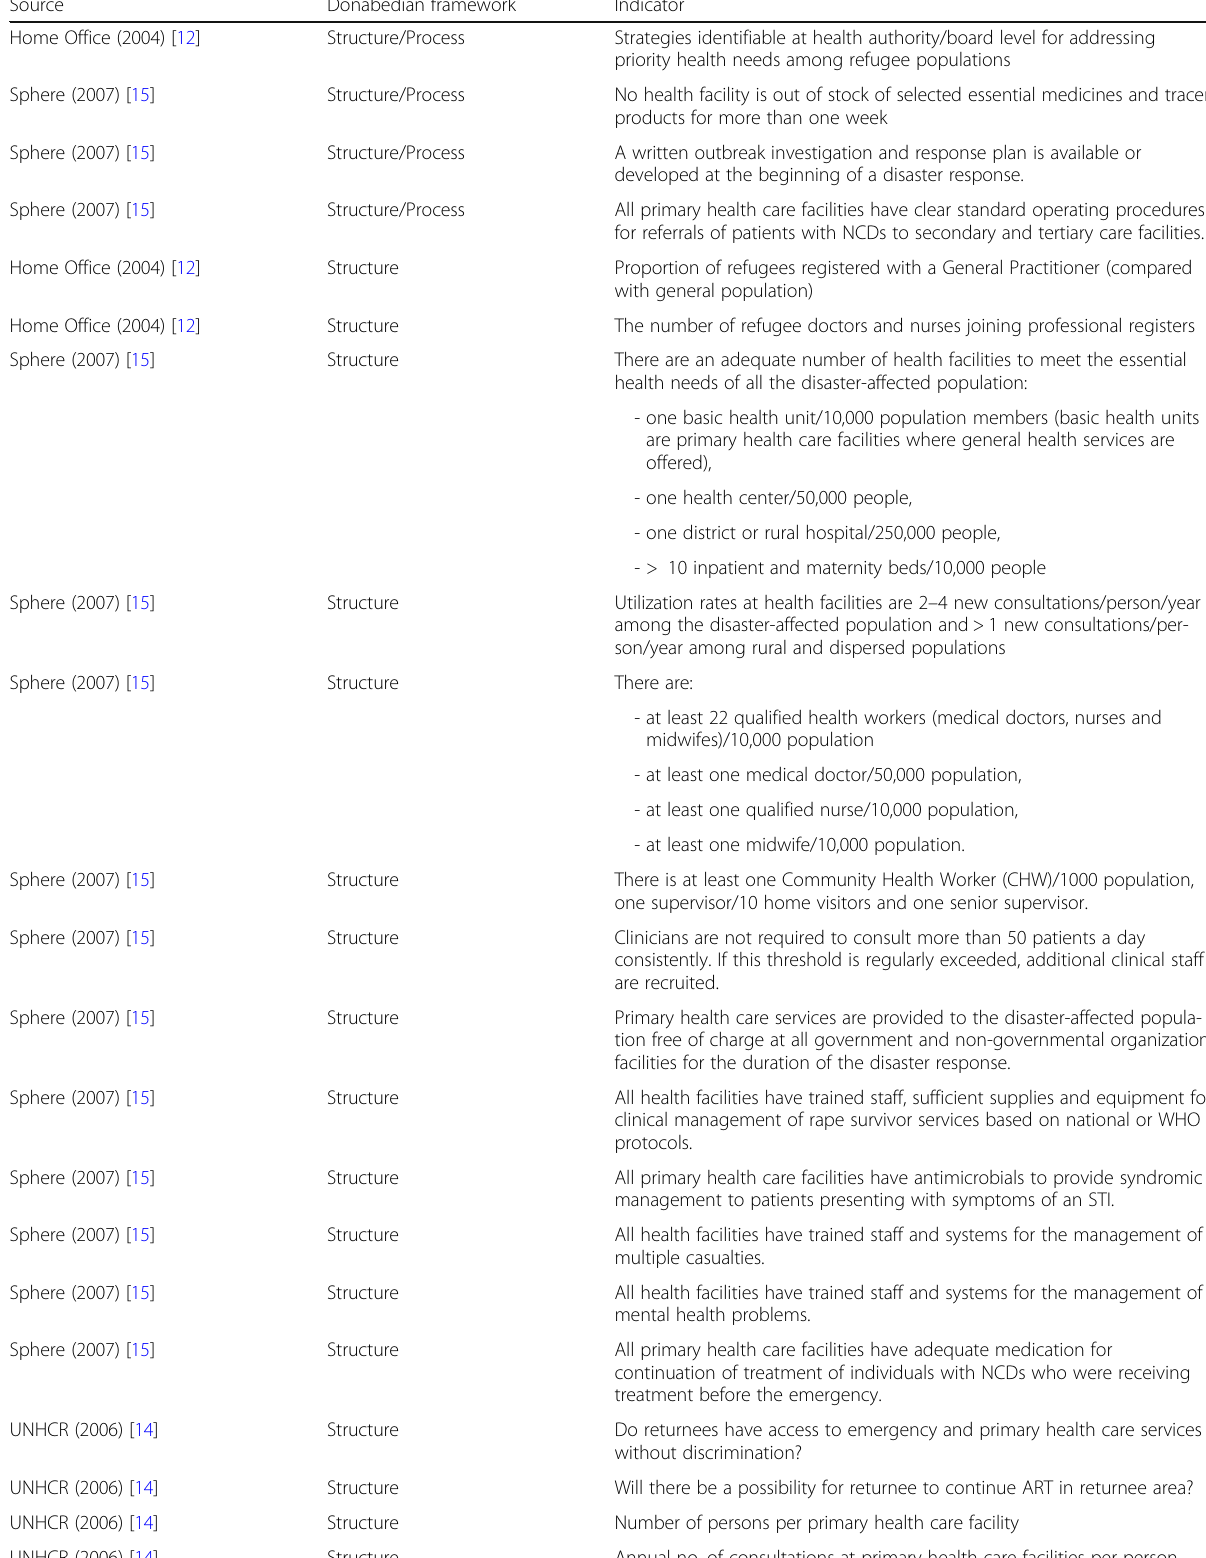
Table 3 Indicators for the topic health care